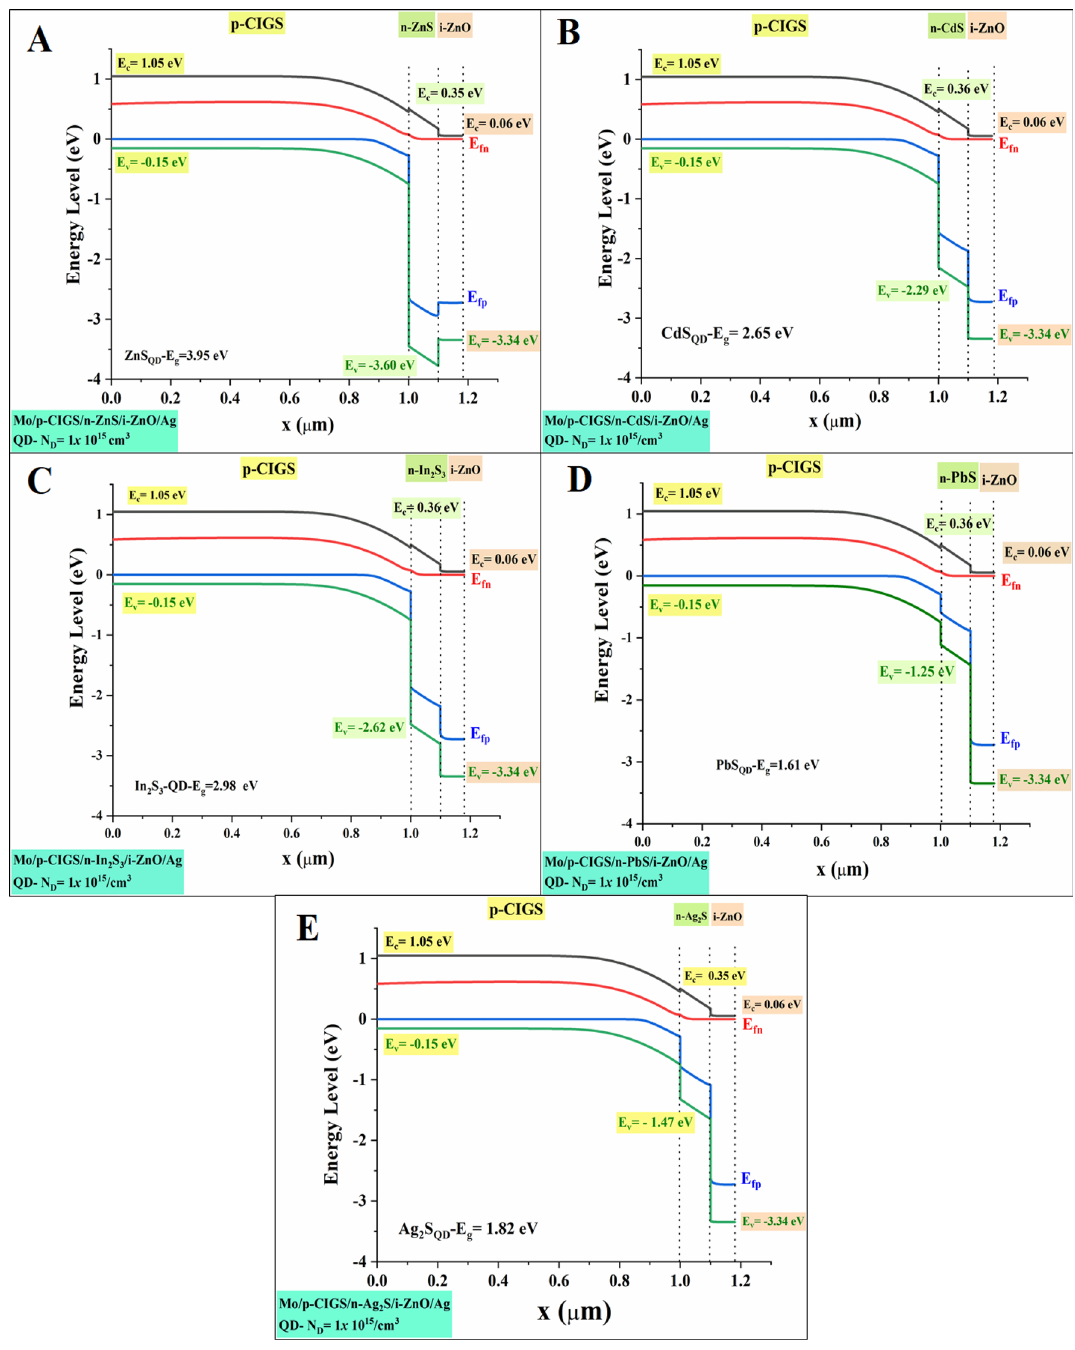
Figure 8. Band diagram at Quantum bandgap at N D = 10 15